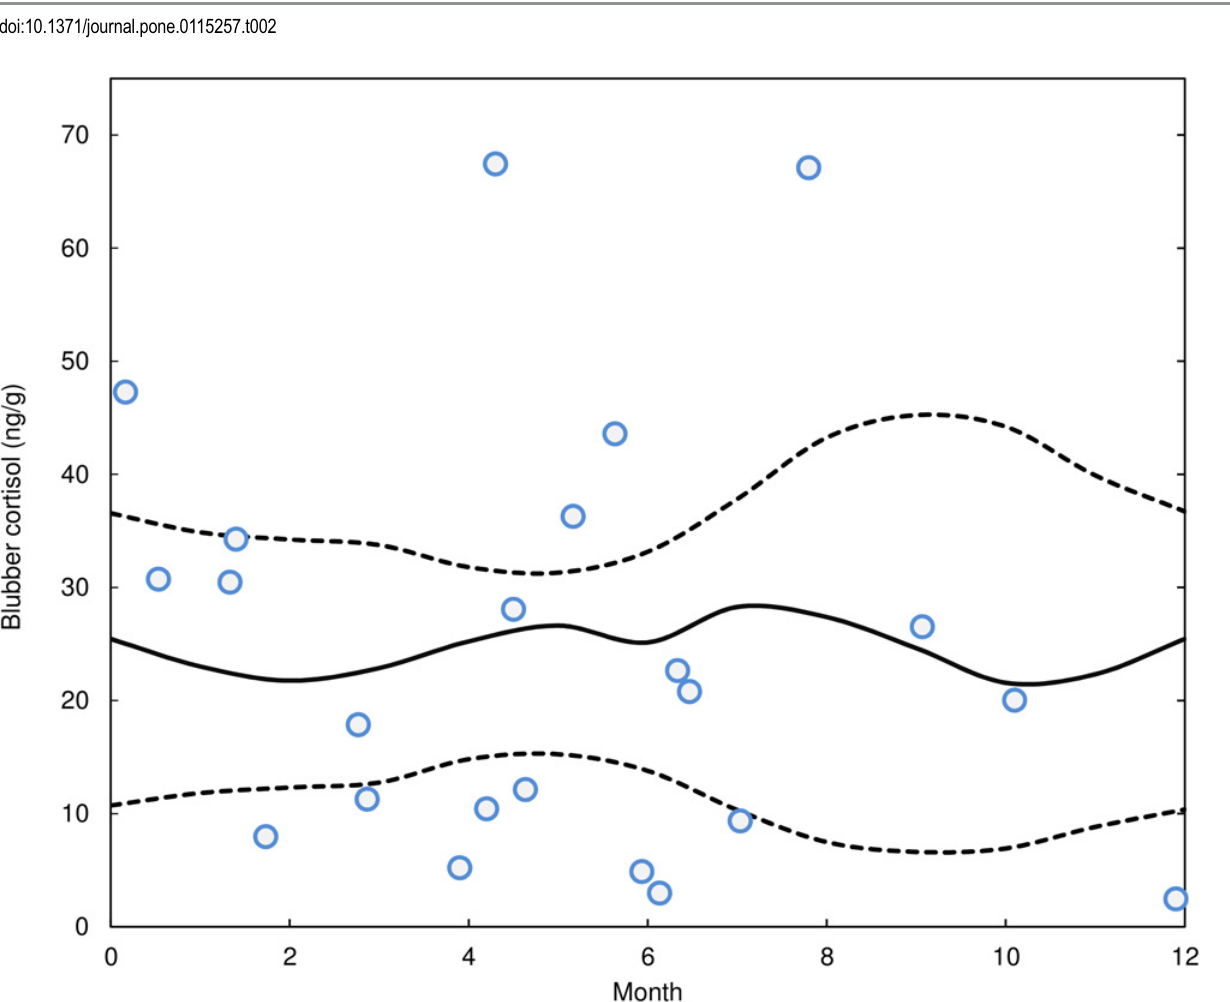
The concentrations are corrected for extraction ef fi ciency (see text) and are reported as ng of cortisol per g of blubber extracted.